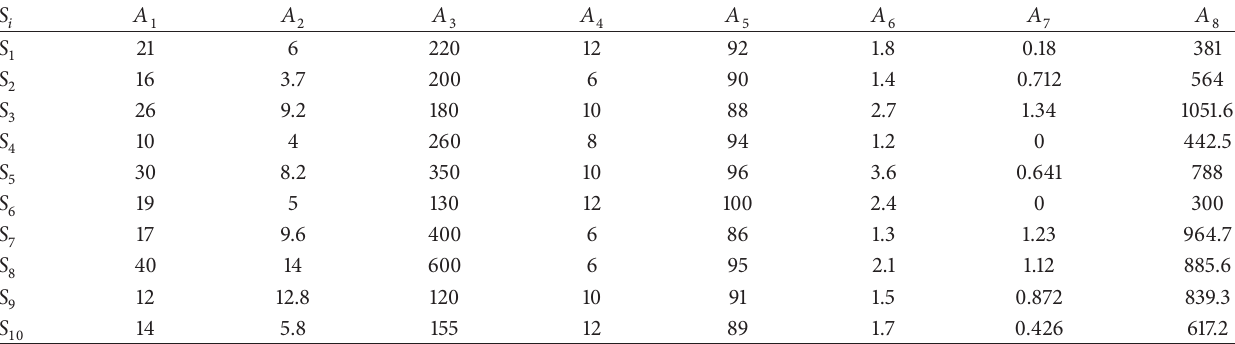
Table 1: Safety data from coal mines.